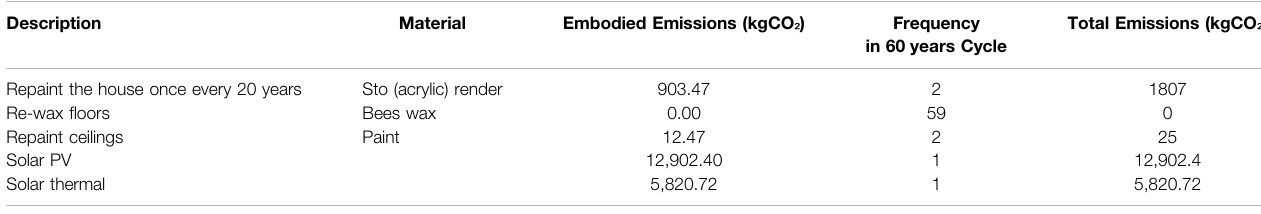
TABLE 7 | Emissions from maintenance.